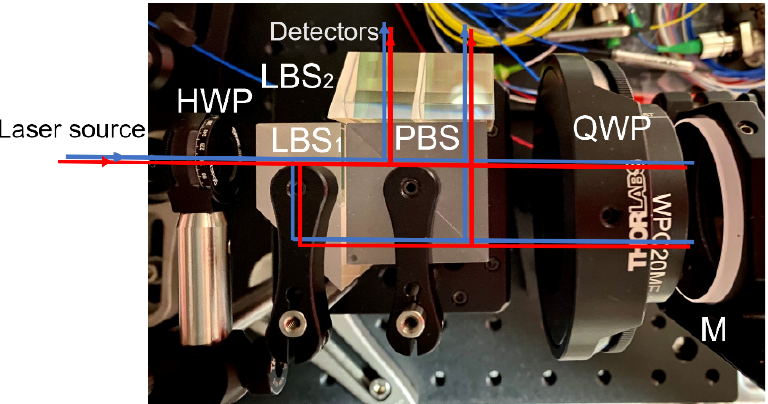
Figure 2. Layout of the benchtop compact heterodyne laser interferometer based on the design depicted in Figure 1. Only one static mirror M is used to characterize the system’s noise floor. Commercial optical and mechanical components are used to construct the benchtop system.